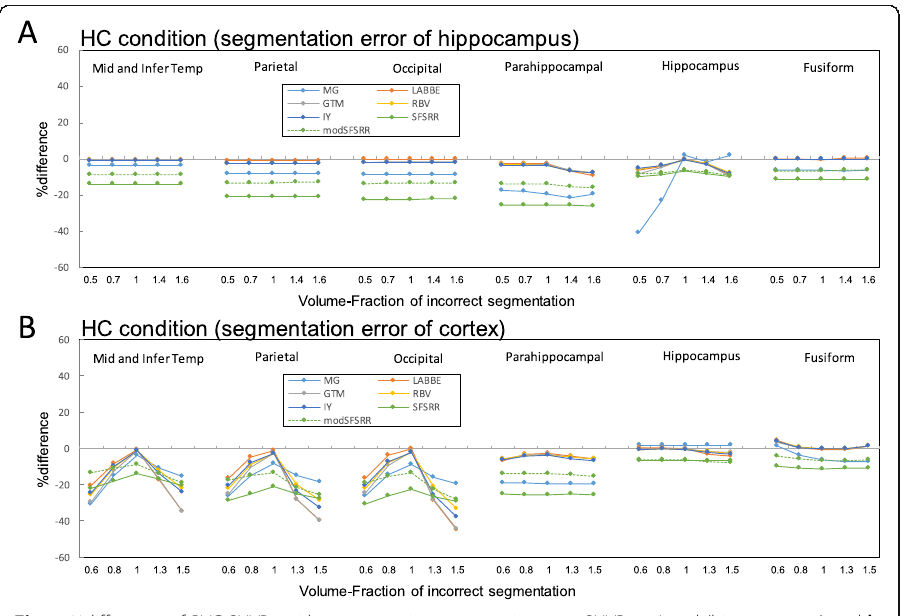
Fig. 7 %difference of PVC-SUVRs with segmentation error against true SUVRs. a Local (hippocampus) and b global segmentation errors. ROI template was from correctly segmented anatomical